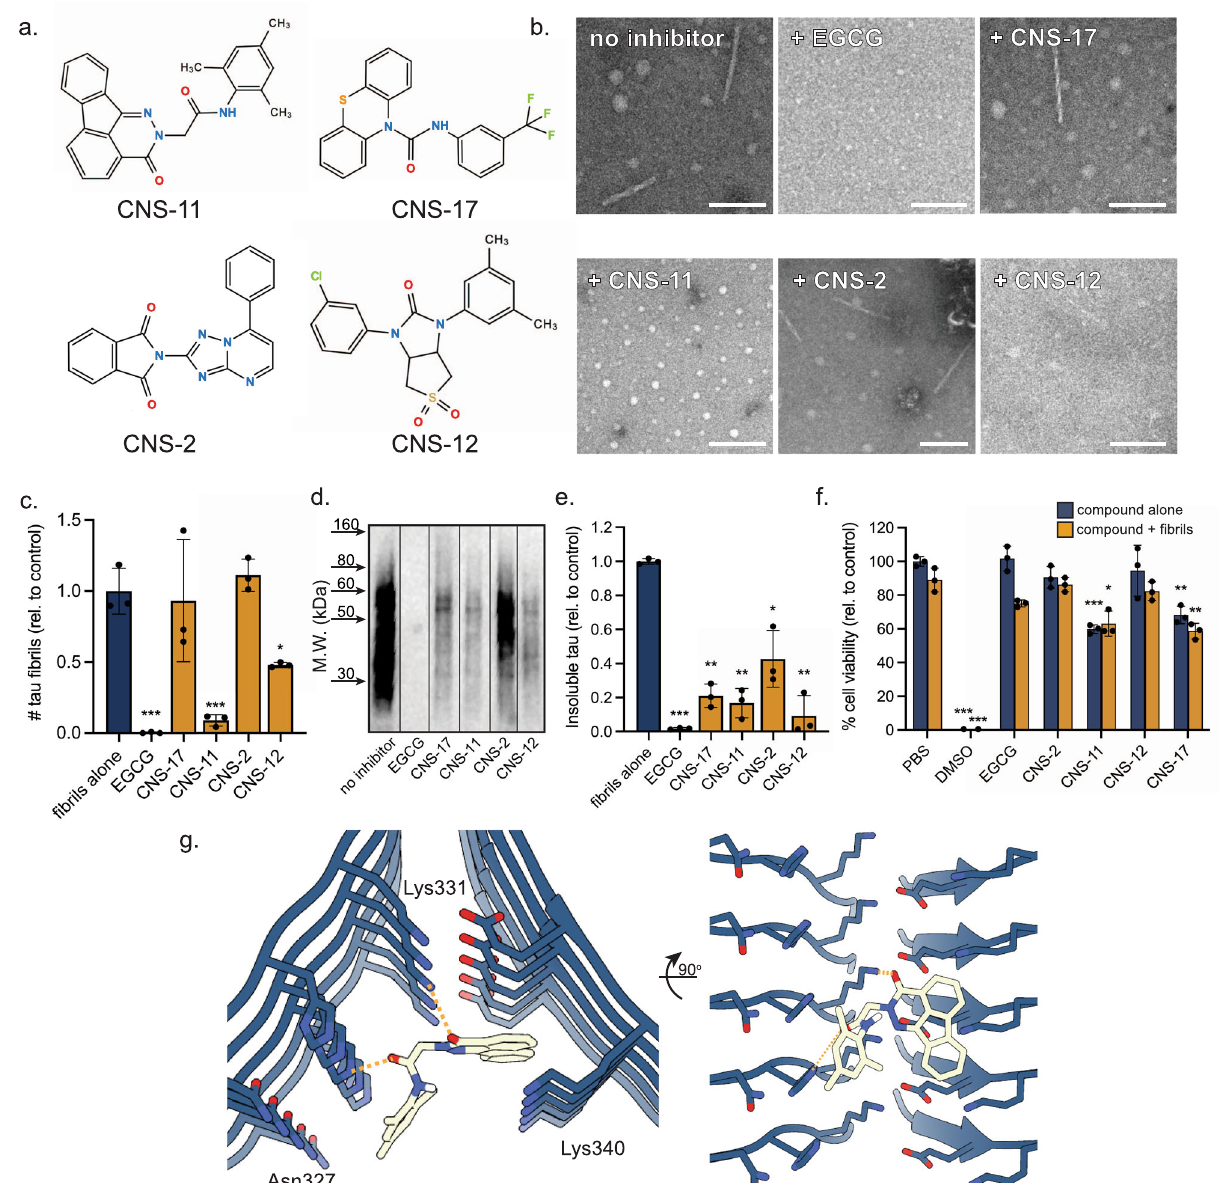
Fig. 3 | Characterization of tau disaggregation by lead compounds. a Top hits fromtheinsilicoandbiosensorcellscreenswereselectedforfurtherexperimental characterization.Four compounds wereselected, CNS-11, CNS-17, CNS-2,and CNS- 12. b Electron micrographs of brain-derived tau fi brils after incubation with each compound,withEGCGascontrol.Few fi brilsareobservedwithEGCGtreatment,as wellaswithCNS-11andCNS-12.Scalebarsrepresent250nm. c Quantitationof fi bril number present on EM images with and without compound treatment. N =33 images were taken from random points on the EM grid, and fi brils were counted. Errorbarsrepresentthestandarddeviationoftriplicatetechnicalmeasurements.A large reduction in visible fi brils is seen for CNS-11. d Brain-derived tau fi brils were treated with compound and the insoluble fraction was analyzed by Western blot,